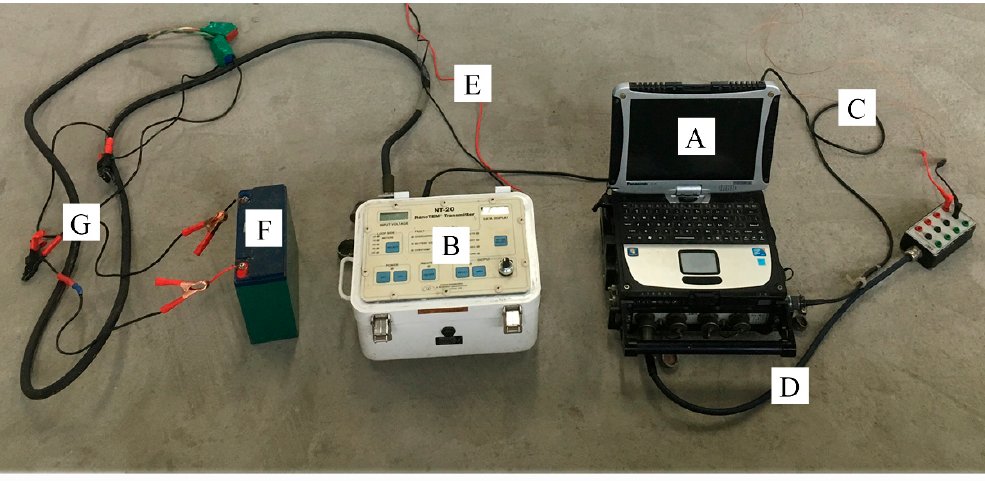
Figure 12. Indoor transient electromagnetic instrument.